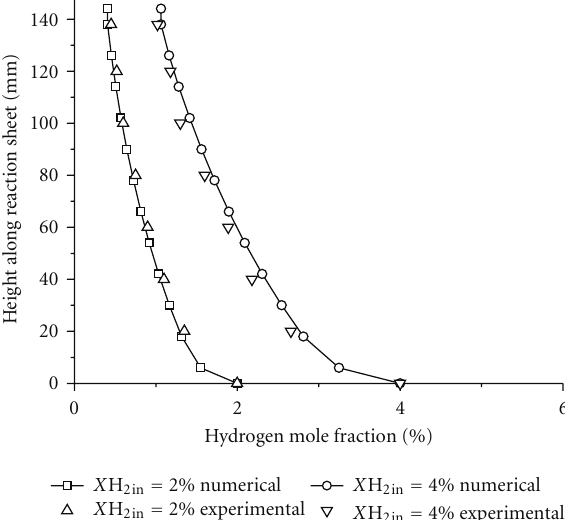
Figure 2: The mesh size sensitivity exercise results for REKO test facility simulation ( V in = 0 . 8m/s, T in = 298 K, X H 2in = 4%). with 60 × 126 × 6, 90 × 168 × 6, 120 × 252 × 12, and 180